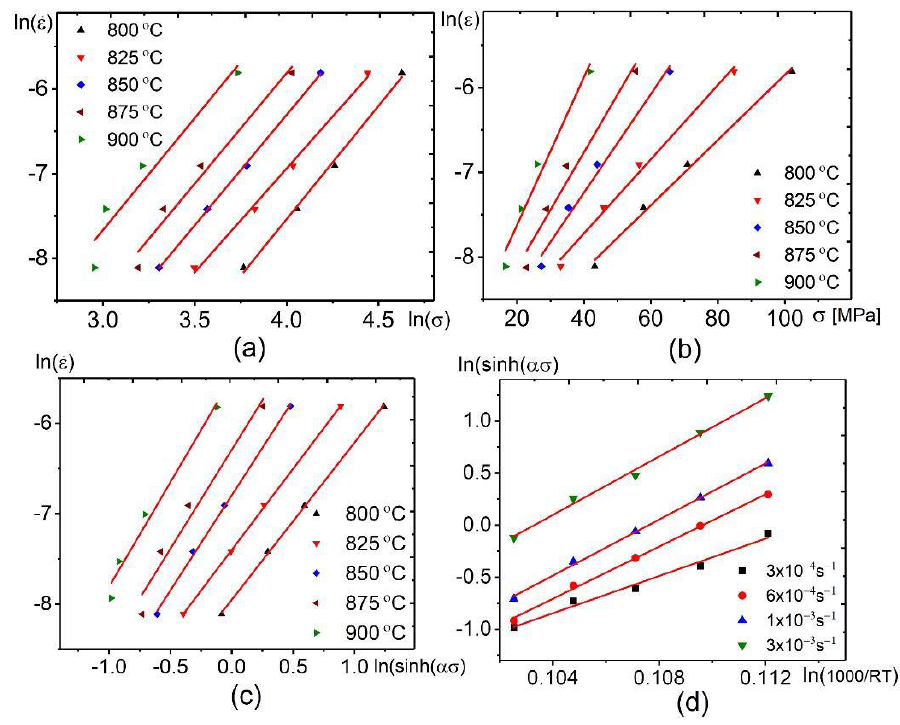
Figure 8. The plots of ( a ) ln 𝜀̇ − ln 𝜎 ; ( b ) ln 𝜀̇ − 𝜎 ; ( c ) plots of ln 𝜀̇ − lnsinh(𝛼𝜎) ; ( d ) ln sinh(𝛼𝜎) − 1000